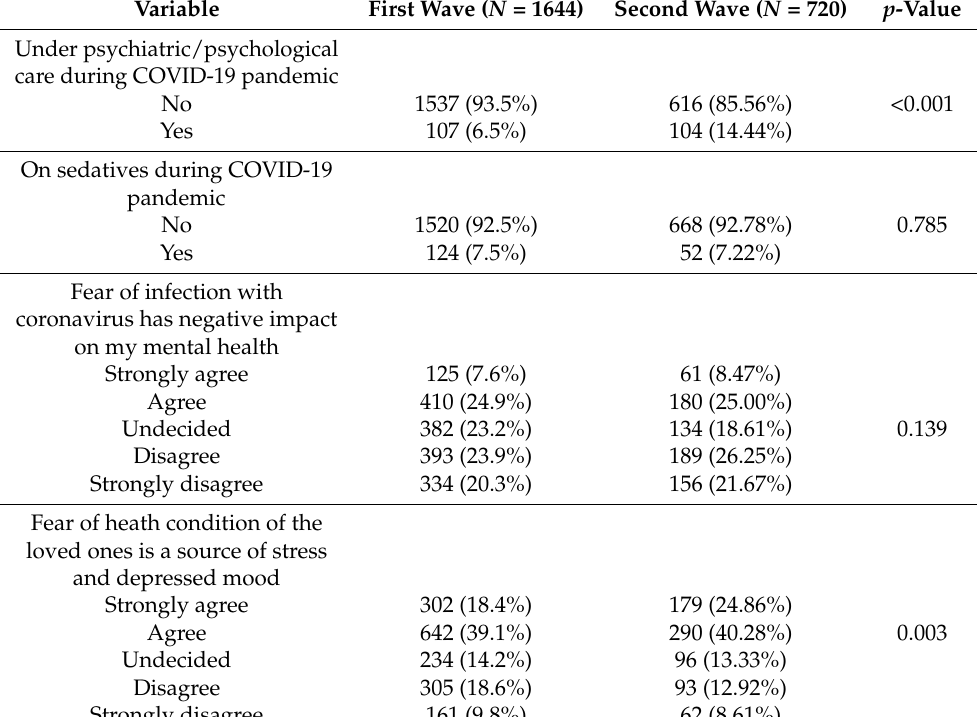
Table A3. Psychological characteristics of the study group during the first and second wave of the COVID-19